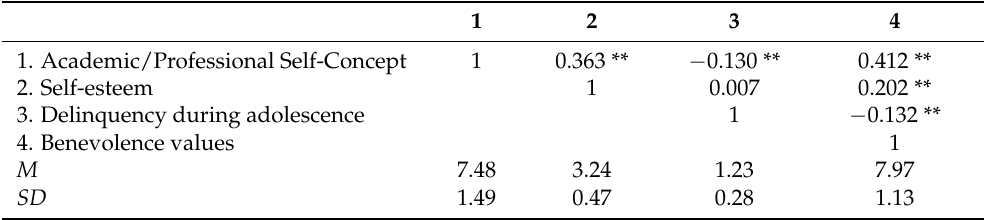
Table 2. Correlations between adjustment criteria, mean and standard